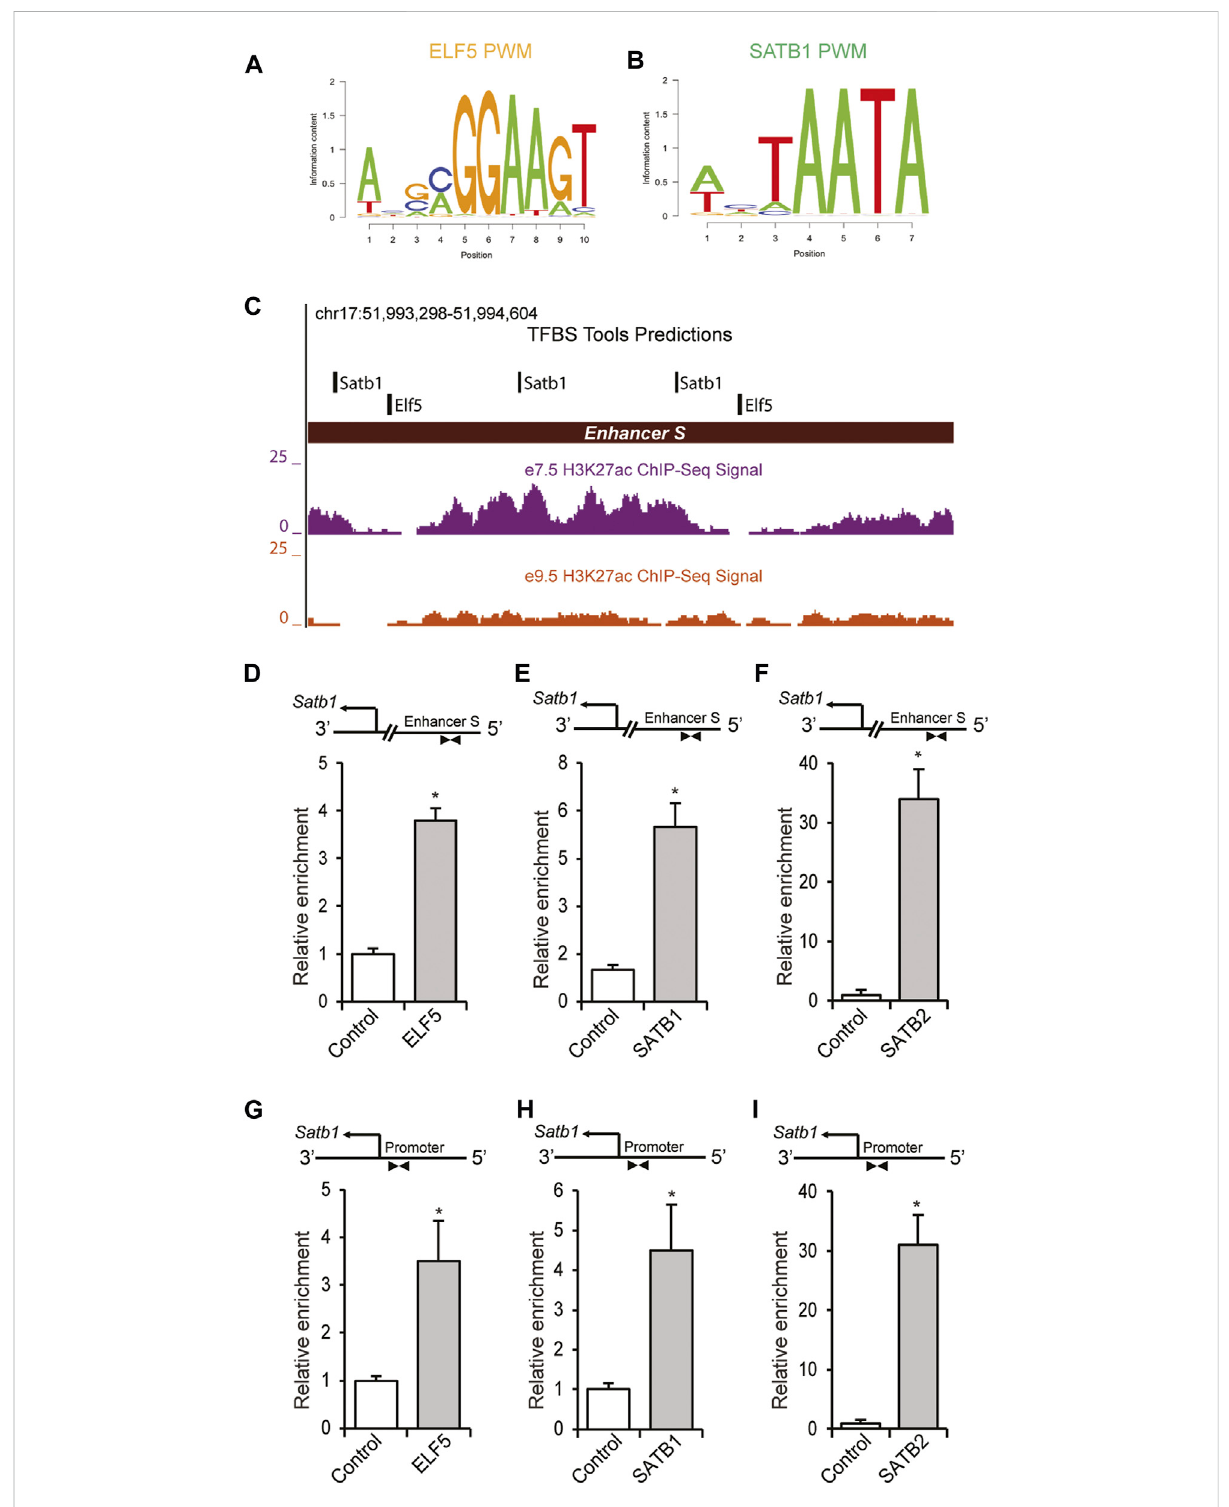
FIGURE 6 ELF5 and SATB proteins bind within the enhancer S in mouse TS cells. (A,B) PWMs of ELF5 and SATB1 used for scanning the enhancer S sequence (Chr17: 51993298 – 51994604) using TFBSTools. (C) Transcription factor binding site analysis by TFBSTools predicted the presence of two ELF5bindingsitesnearSATB1bindingsiteswithin enhancerS. ChIPassaysalsodemonstratedsigni fi cantenrichmentofELF5,SATB1andSATB2inthe enhancer locus of mTS cells (D – F) . (G – I) , In addition to the enhancer region, binding of ELF5, SATB1, and SATB2 was detected in the Satb1 variant 2 promoter in mTS cells. ChIP-qPCR data are expressed as the means ± S.D. * p < 0.05 ( n =